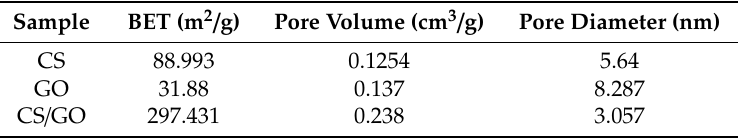
Table 2. Hole structure analysis of the